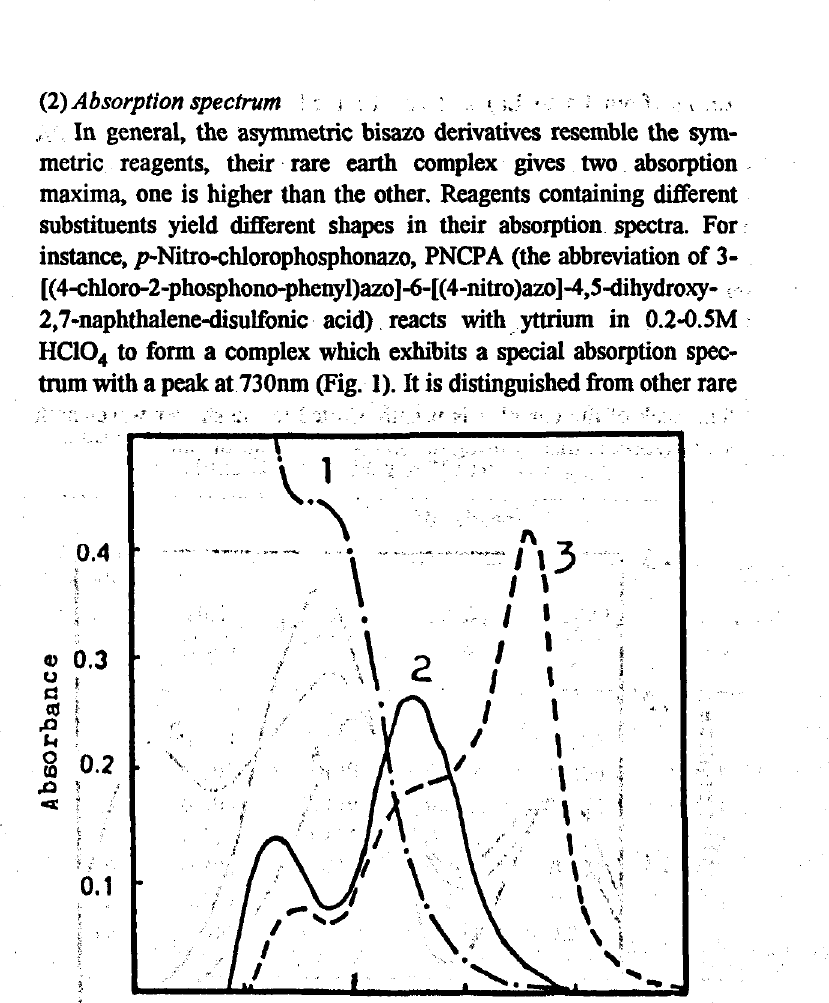
Fig. 1 Absorption spectra of PNCPA complexes of Ce and